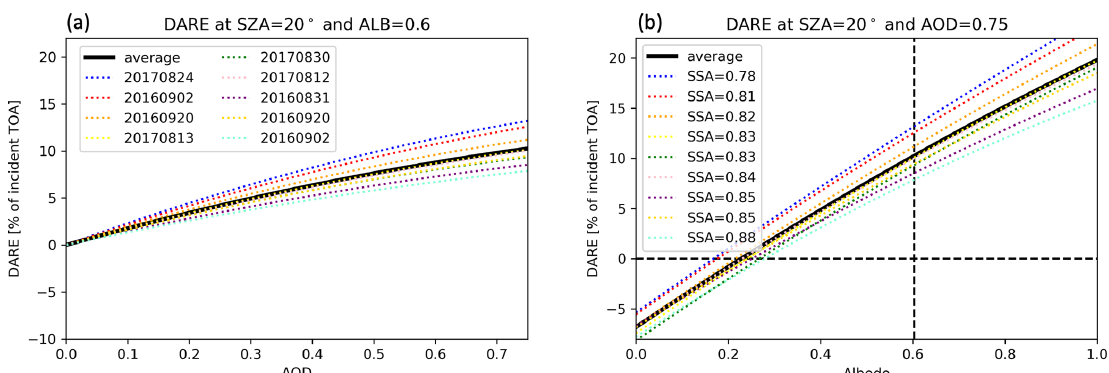
Figure 5. (a) DARE as a function of AOD for fixed underlying albedo (0.6) and SZA (20 ◦ ), shown for the individual nine cases from this study (colors) and the average (black). The average is the basic parameterization result, P DARE . (b) DARE as a function of underlying albedo for a fixed AOD (0.75). The individual cases are labeled by their SSA at 550nm (from more to less absorbing). The albedo at which the DARE changes is the critical albedo (horizontal dashed line). The vertical line marks an albedo of 0.6 for much of the ensuing discussion, which uses an AOD of 0.75, an albedo of 0.6, and a SZA of 20 ◦ . It should be noted that a 20 ◦ SZA is not representative of the mean in the